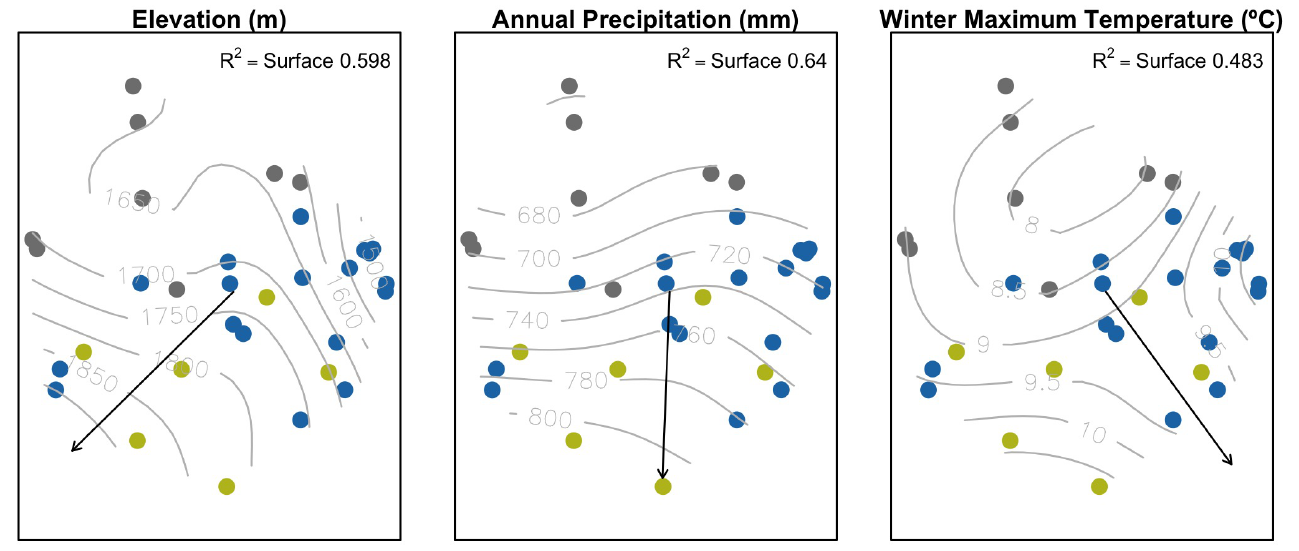
Figure 5. NMDS ordination with fitted environmental vectors and regression surfaces. Length and direction of the arrows indicate the strength and sign of the linear correlation of environmental variable with ordination scores. The surfaces show smooth trends of the relationship between environmental variables and plot